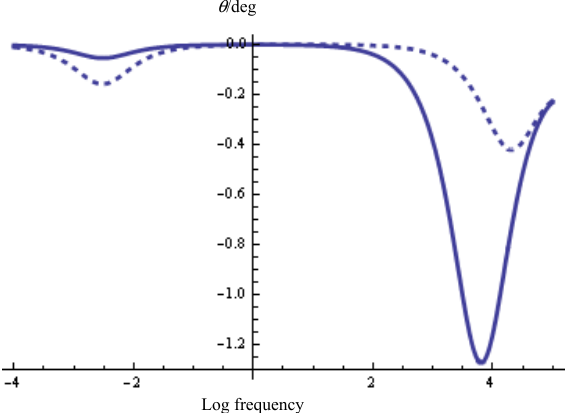
Fig. 2.C: Phase Spectra for suspensions of large cells ( R 1 ~ 0.5 mm), Δϕ 0 = -150 mV; σ 2 = 10 -6 S/m (solid line); σ 2 = 10 -5 S/m (dashed)